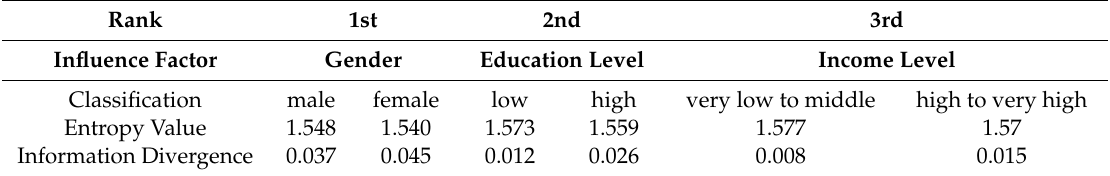
Table 2. Top three distinguishable factors for carbon footprint